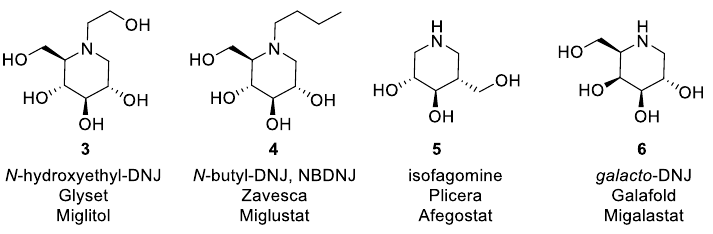
Figure 3. Marketed iminosugars.